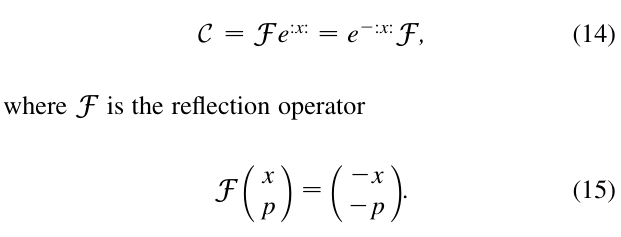
FIG. 2. Phase space in normalized variables, showing separa- trices delimiting the phase space and an elliptical ring in phase space at 11 points in the acceleration process from p (cid:2) 0 to p (cid:2) 1 .